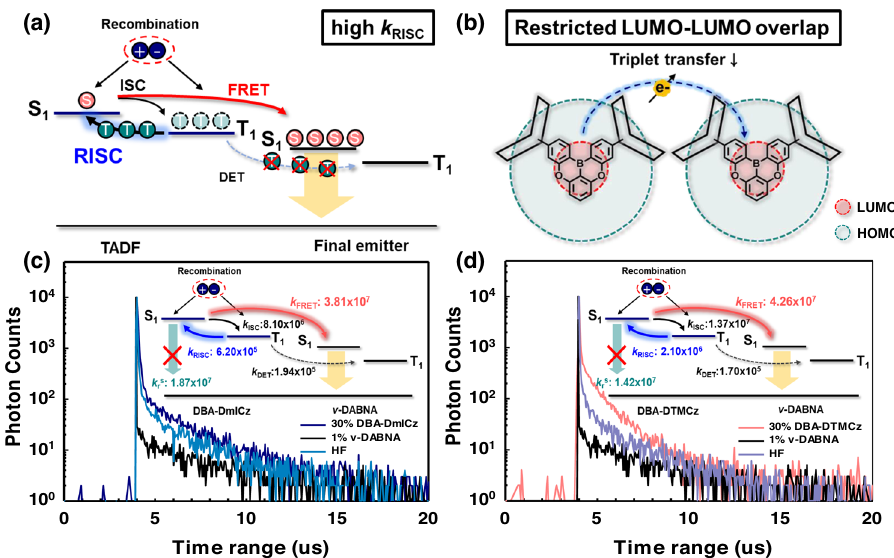
Fig. 6 | Schematic diagram for exciton transfer in HF system. Illustrations with respectto a rateconstantofRISCprocessand b LUMOandLUMOoverlapping.The TRPLmeasurementTADF, fi nialemitter,andHFsystemutilizing c DBA-DmICz,and